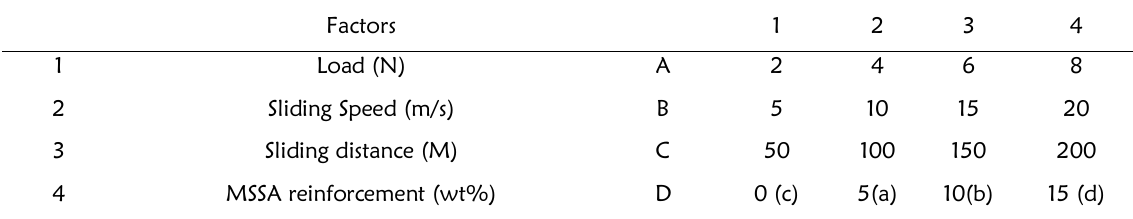
Table 2: Taguchi L16 orthogonal array